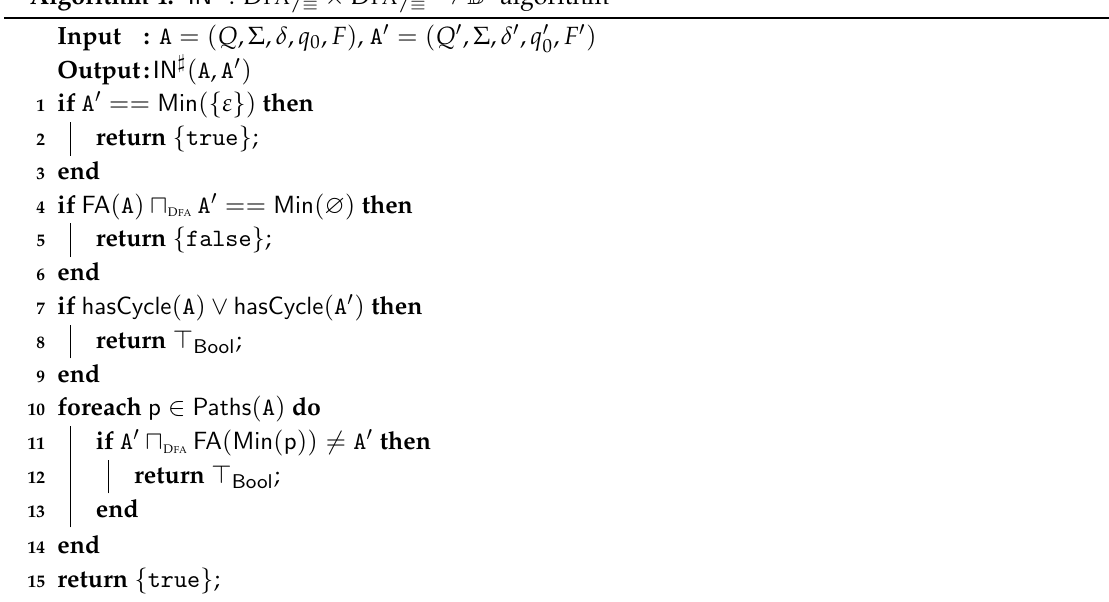
Algorithm 4: IN (cid:93) : D FA / ≡ × D FA / ≡ → B (cid:93) algorithm